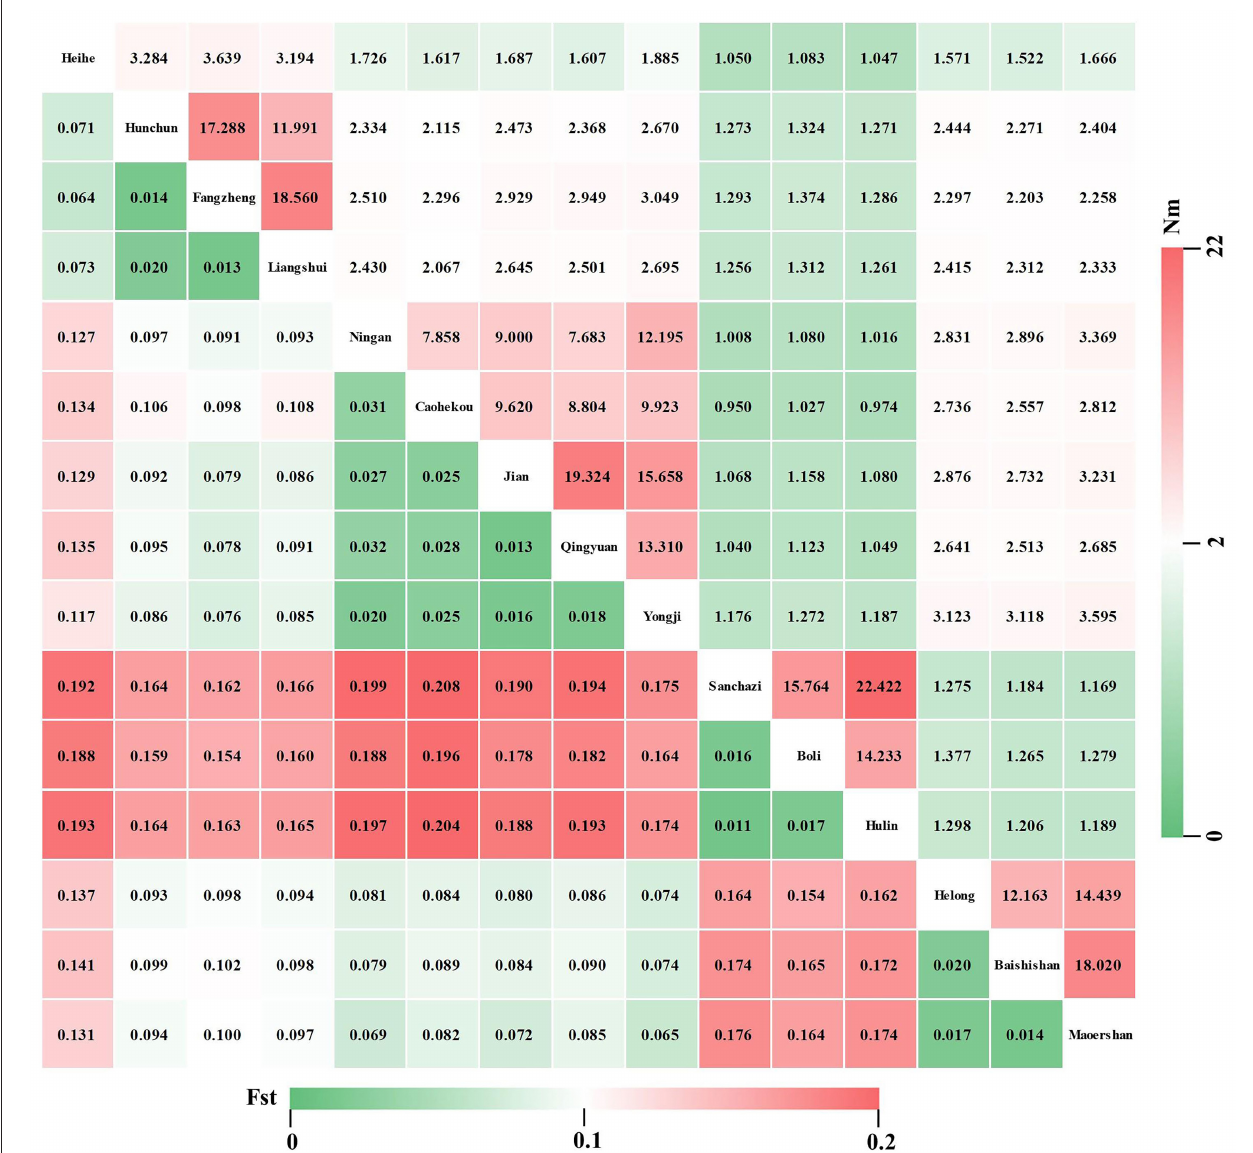
FIGURE 7 | Genetic differentiation coefficient (lower left) and gene flow (upper right) among different populations of J. mandshurica .